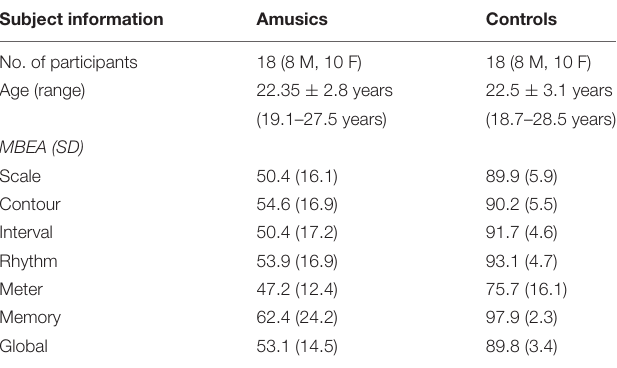
TABLE 1 | Demographic characteristics of the amusic and control